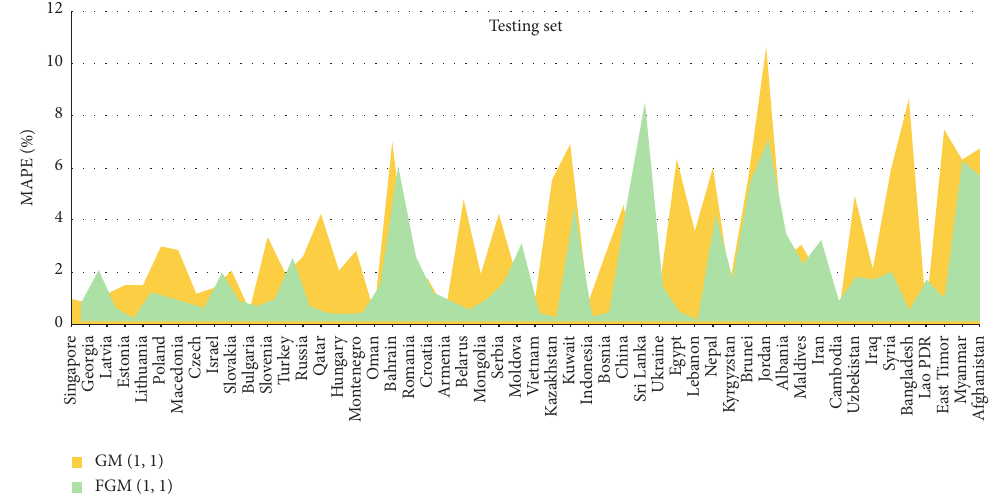
Figure 4: MAPE comparison between GM (1, 1) and FGM (1, 1) in the testing